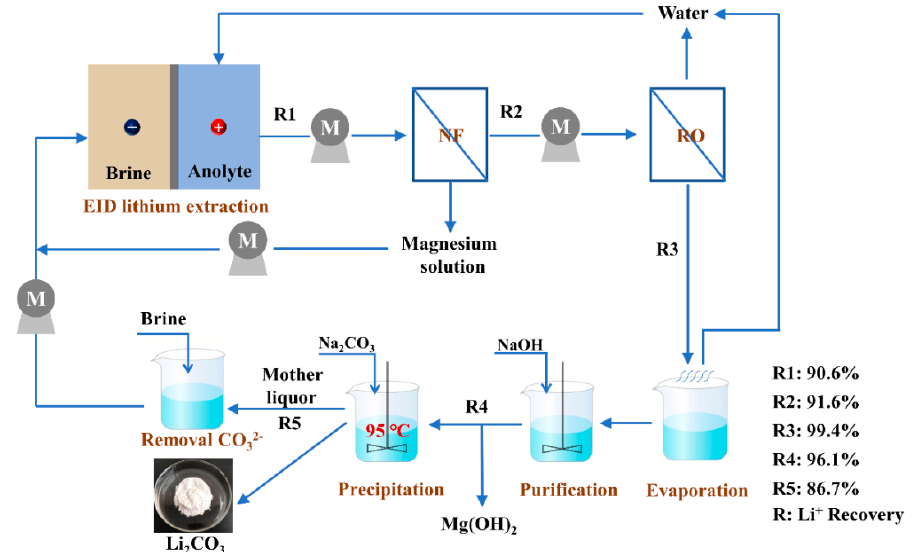
Figure 1. Schematic diagram of the comprehensive membrane process. EID, electrochemical intercalation-deintercalation; NF, nanofiltration; RO, reverse osmosis.